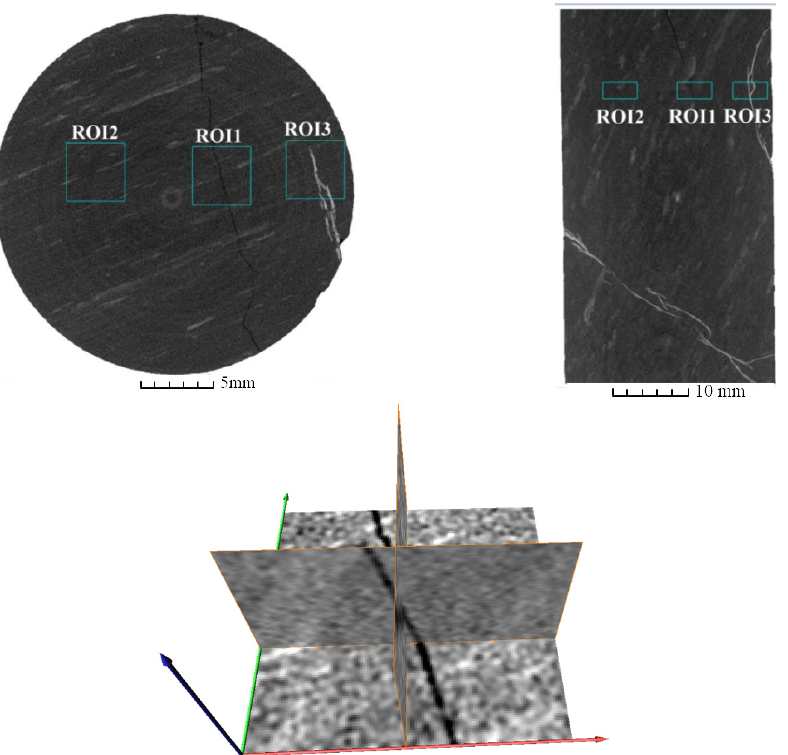
Figure 2. Positions of ROI1, ROI2, and ROI3 (top left: top view of CT image; top right: side view of CT image) and slices in 3 dimensions of ROI1 (bottom).